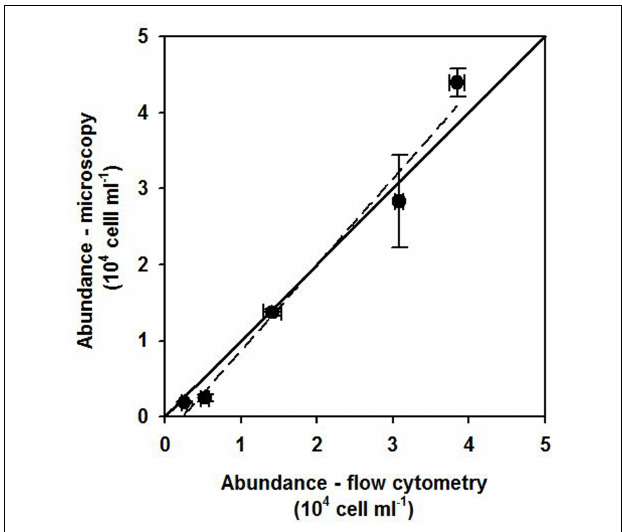
FIGURE 1 | Comparison between flow cytometry and microscopy SP counts for time points were FLB experiments were carried out at station 1 in December 2015 and May 2016 The solid line indicates a 1:1 ratio and the dashed blacked line the linear regression for the data points ( R 2 :